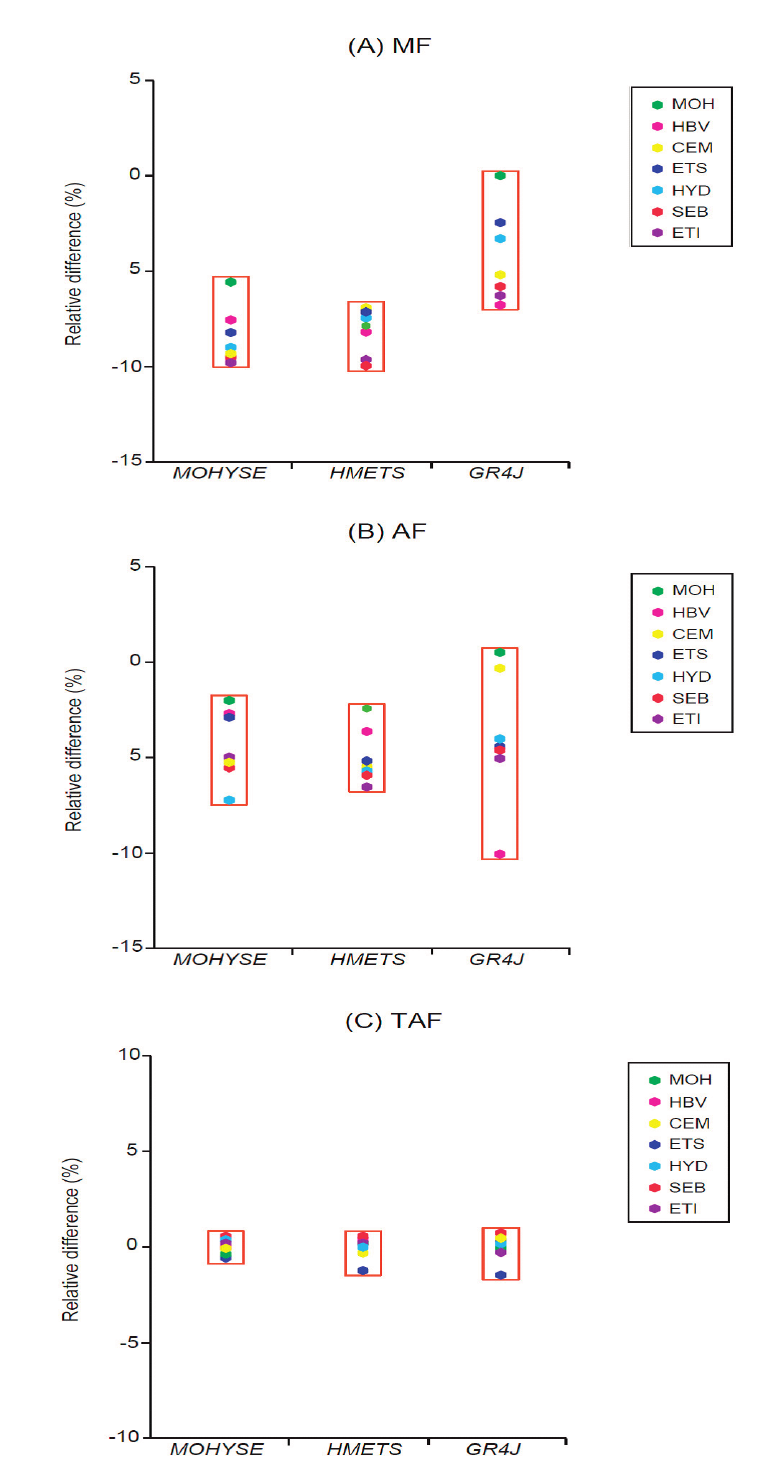
Figure 12. Relative difference (%) of the investigated indicators (the mean high flow (MF), the annual extreme flood (AF) and the timing of the annual extreme flood (TAF)) for each hydrological model over the 1961–2000 period. The boxes indicate the ensemble simulations and the color dots specify the seven snow models, ( A ) MF; ( B ) AF; ( C )